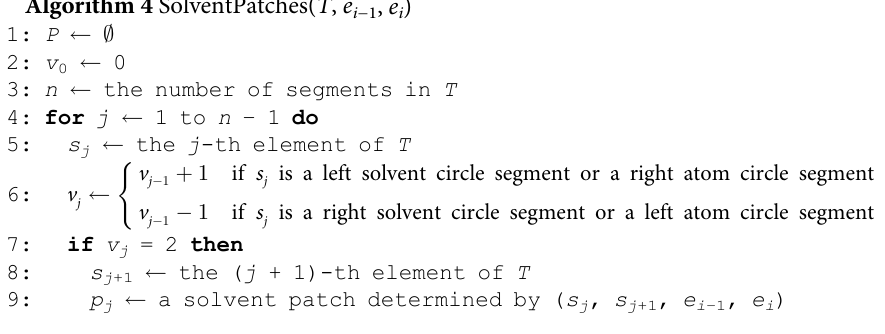
Algorithm 4 SolventPatches( T , e